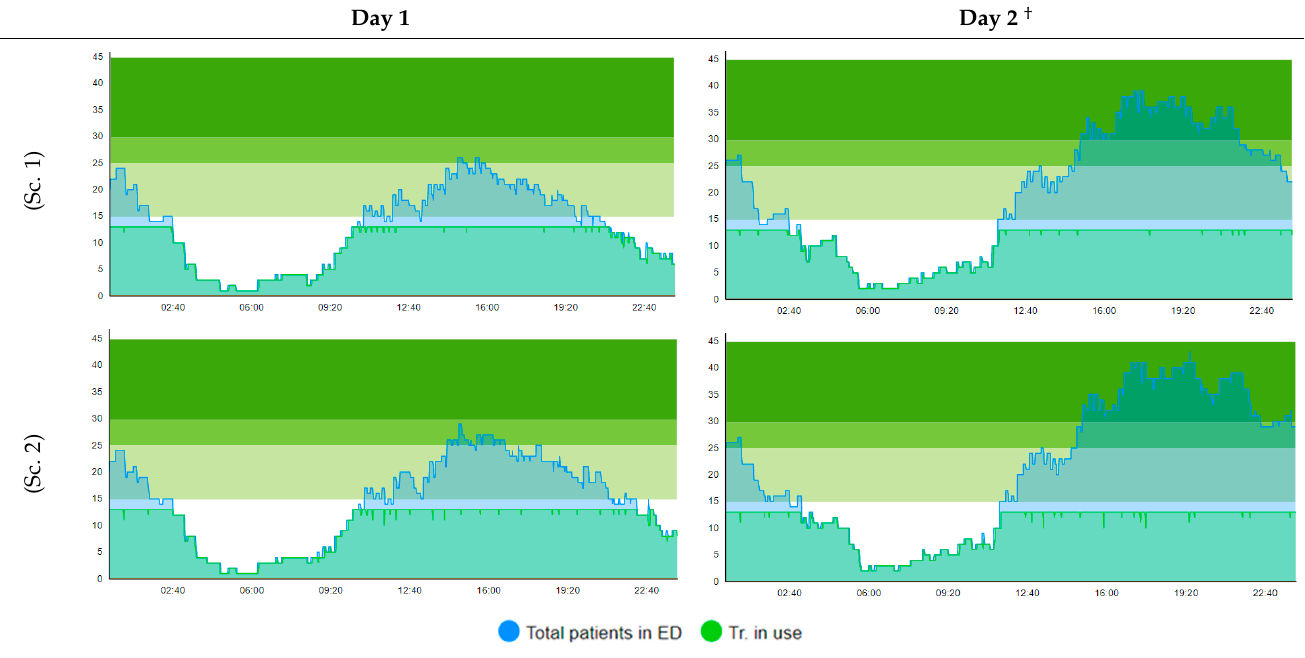
Table 8. Simulation output crowding graphs for comparison between Sc.2 and Sc.1.